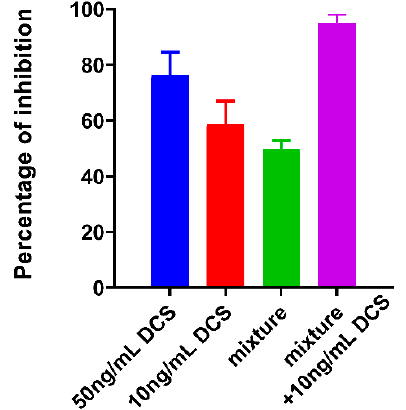
Figure 8. Effect of DCS on C. jejuni 11168-O biofilm when combined with a mixture of L-ala, D-ser, D- met, D-trp (5:5:2:5 mM). The data is presented as Mean ± Standard errors of Percentage of inhibition (Normalized to untreated control).